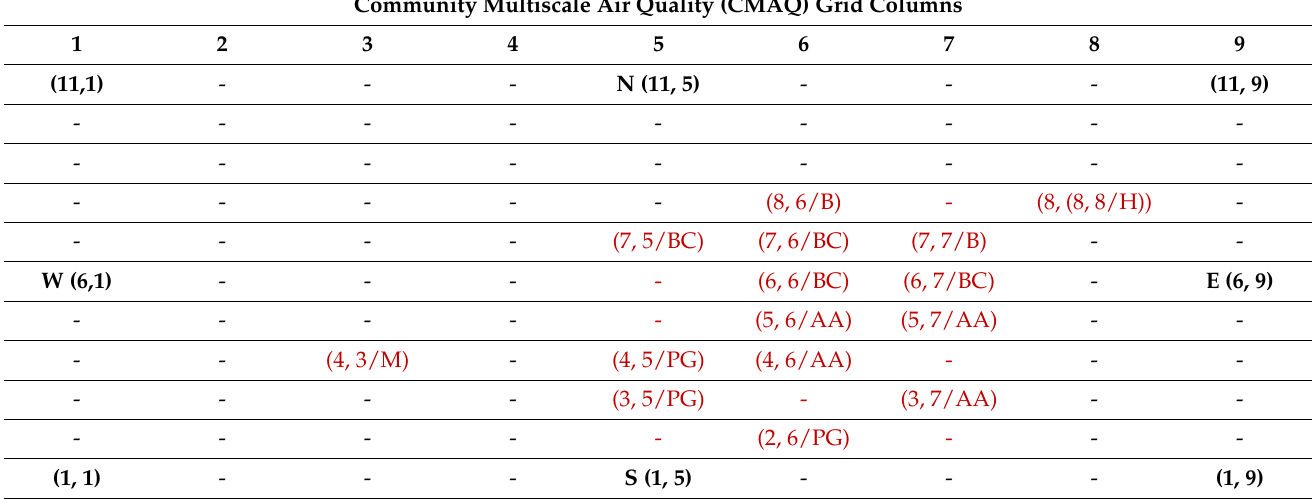
Table 1. Bidirectional spatial lag grid case-crossover analyses for the 99 12 km 2 CMAQ grids with (red) and without (dash, ‘-‘) ambient PM 2.5 air monitors in the Baltimore study area 1 − 3 . Community Multiscale Air Quality (CMAQ) Grid